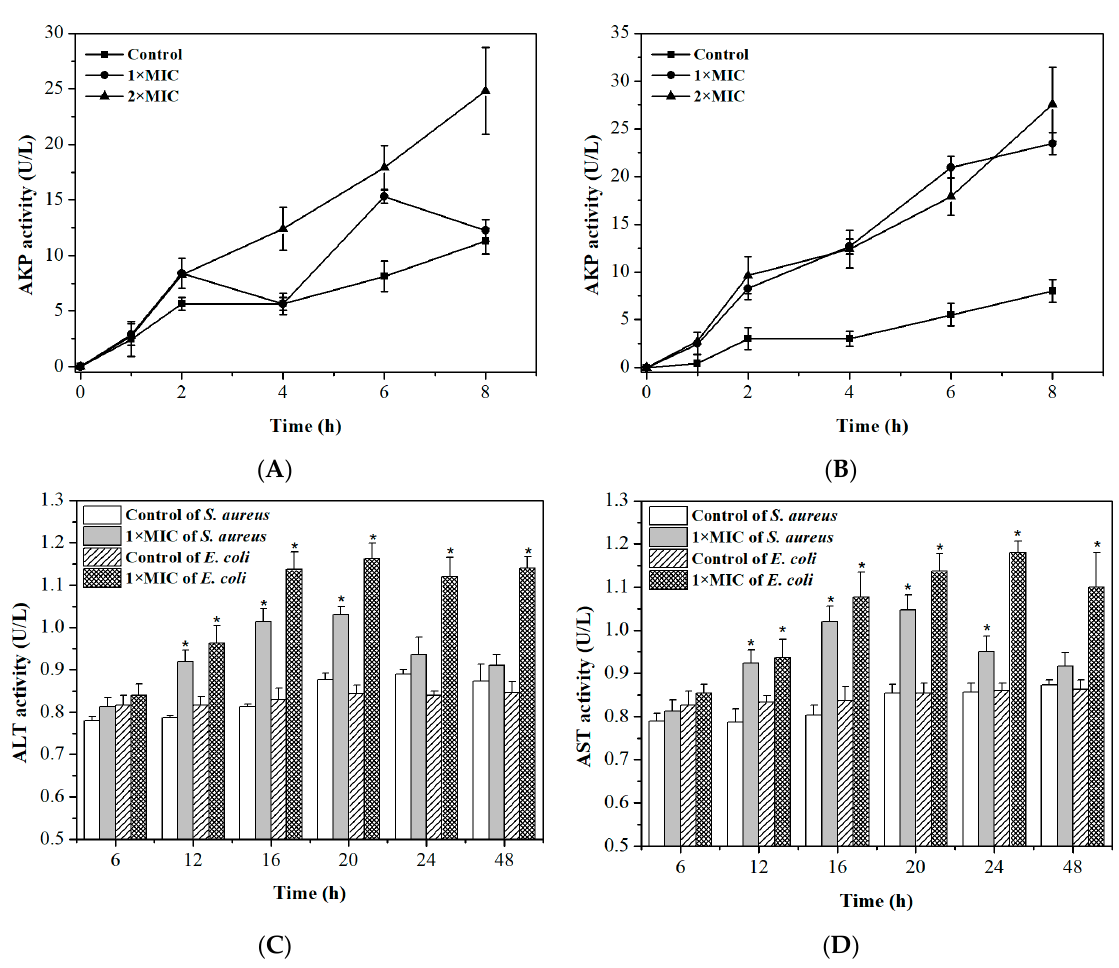
Figure 4. Alkaline phosphatase (AKP) activity of S. aureus ( A ) and E. coli ( B ) before and after DMY treatment. ( C ) Alanine transaminase (ALT) and ( D ) aspartate transaminase (AST) activity of S. aureus and E. coli before and after DMY treatment. * p < 0.05 versus the control group.